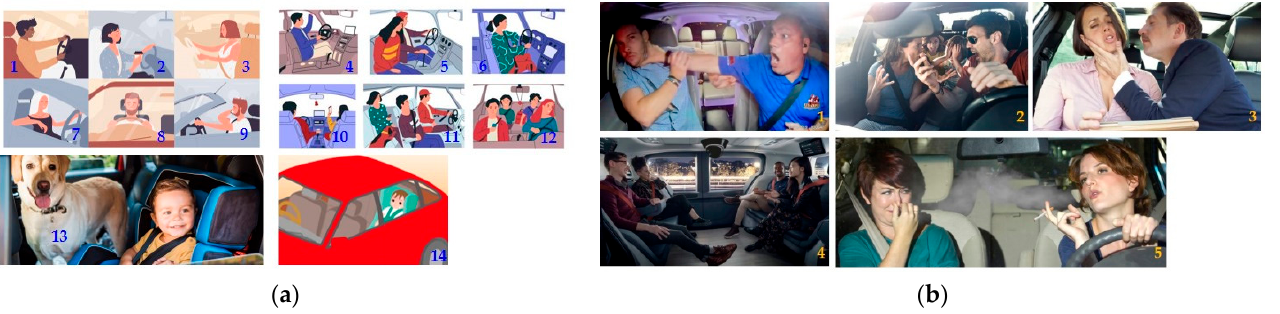
Figure 3. An illustration of ( a ) the safety (for example, no seatbelt: 1, 5, 11; drinking and drive: 2; drowsy and driving: 3; body part outside the vehicle: 4, 7; distracted driving: 6, 9, 10, 12; tense driving: 8; and unattended child and pet: 13, 14). ( b ) Illustration of the security issues in level 4 and beyond AVs (for example vandalism: 1; violence and argument: 2; harassment: 3; personal privacy breach during monitoring in public: 4; discomforted due to smoking: 5).